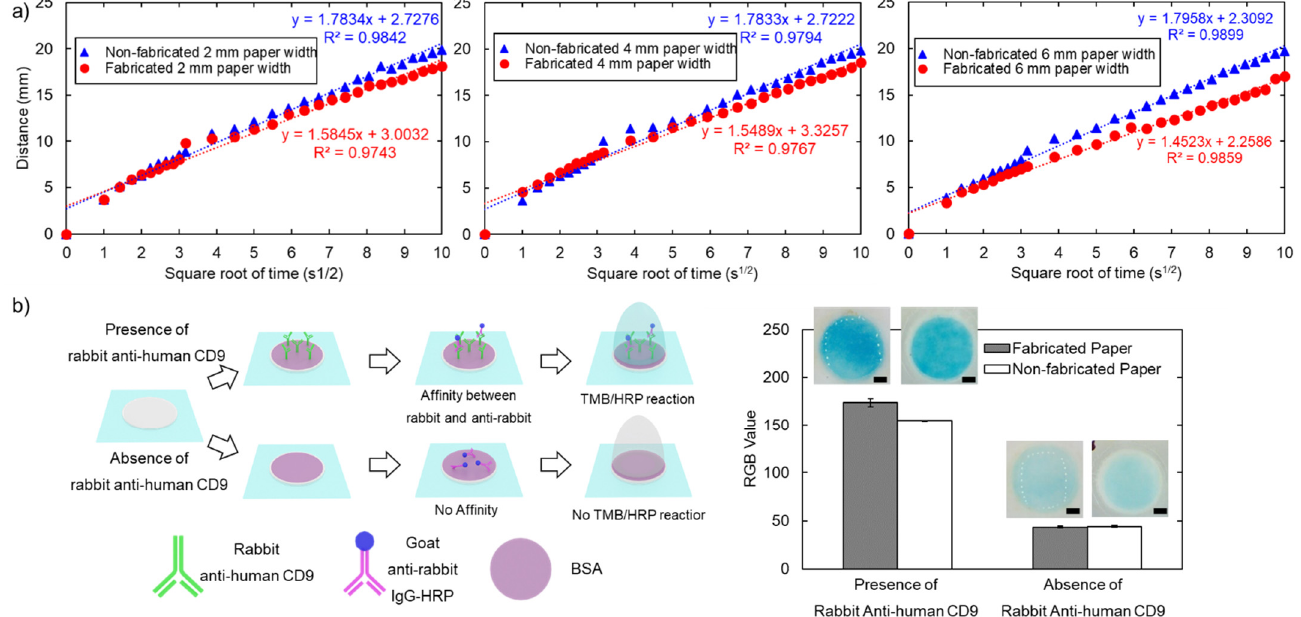
Figure 9. Physical and biochemical properties of the paper: ( a ) flow characteristics resulting from 2-mm, 4-mm and 6-mm paper strips. A blue marker for original paper and a red marker for fabricated paper; ( b ) schematic diagram for colorimetric immunological assay in the presence and absence of rabbit anti-human CD9 with the bar diagram for RGB value quantified at the 20th minute of the TMB/HRP assay with MATLAB between fabricated (grey bar) and non-fabricated paper (white bar). Error bars represent the standard deviation from the average of three replicates ( n = 3) . Scale bar is 1 mm.